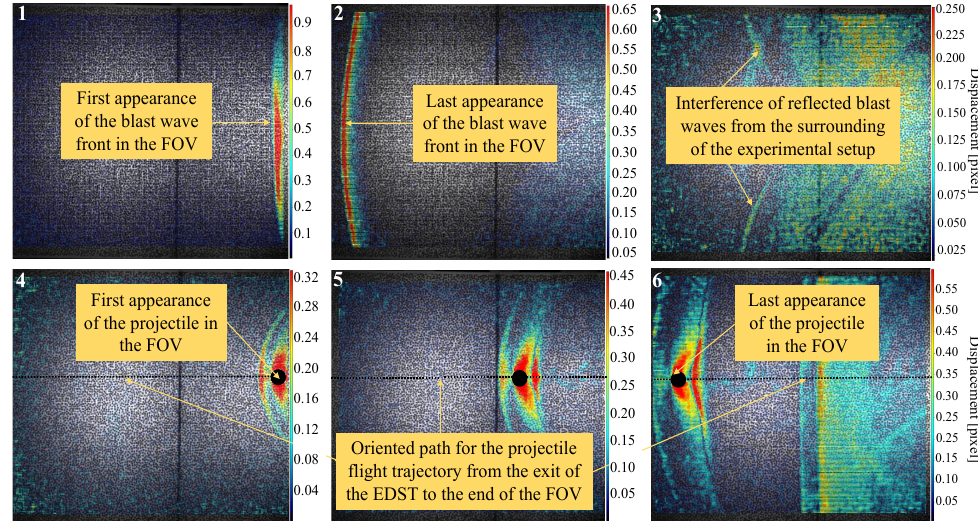
Figure 6. Images obtained from the HSC are processed using PIV technique and show an oriented path for the flight trajectory of a 7 mm diameter projectile: (i) images 1 to 3 represent the propagation of the blast wave in the camera field of view, (ii) images 4 to 6 depict the main features of the flow field around the freely flying projectile.